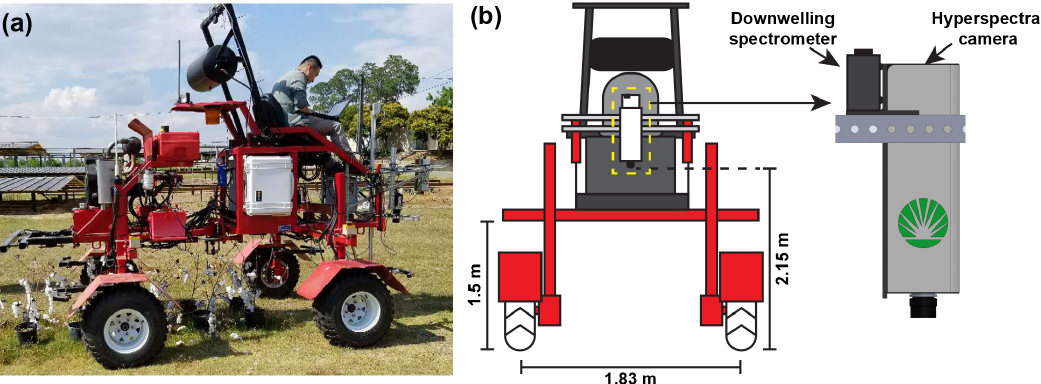
Figure 1. Illustration of data collection system: ( a ) picture of the “GPhenoVision” system and ( b ) diagram of the system configuration and sensor